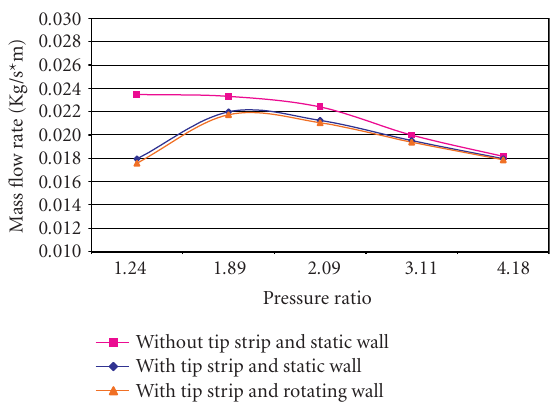
Figure 14: E ff ect of tip strip and impeller rotation on rotor-casing leakage.